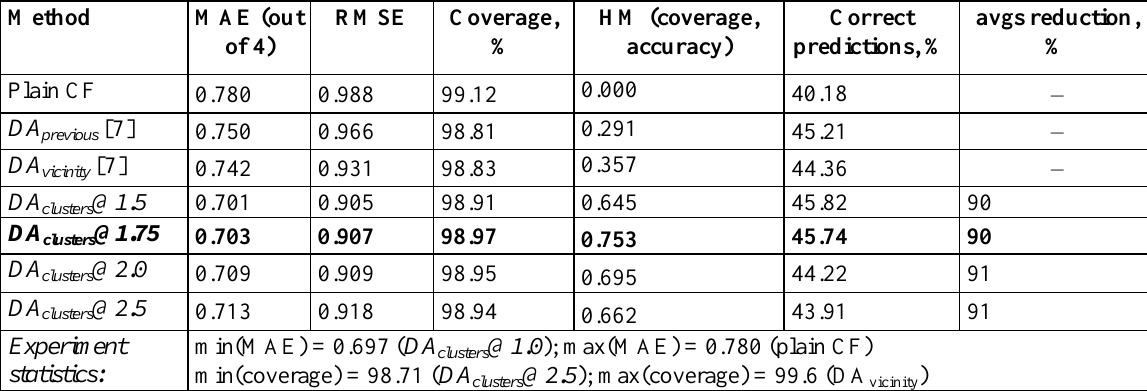
Table 9. “NetFlix Competition” dataset results